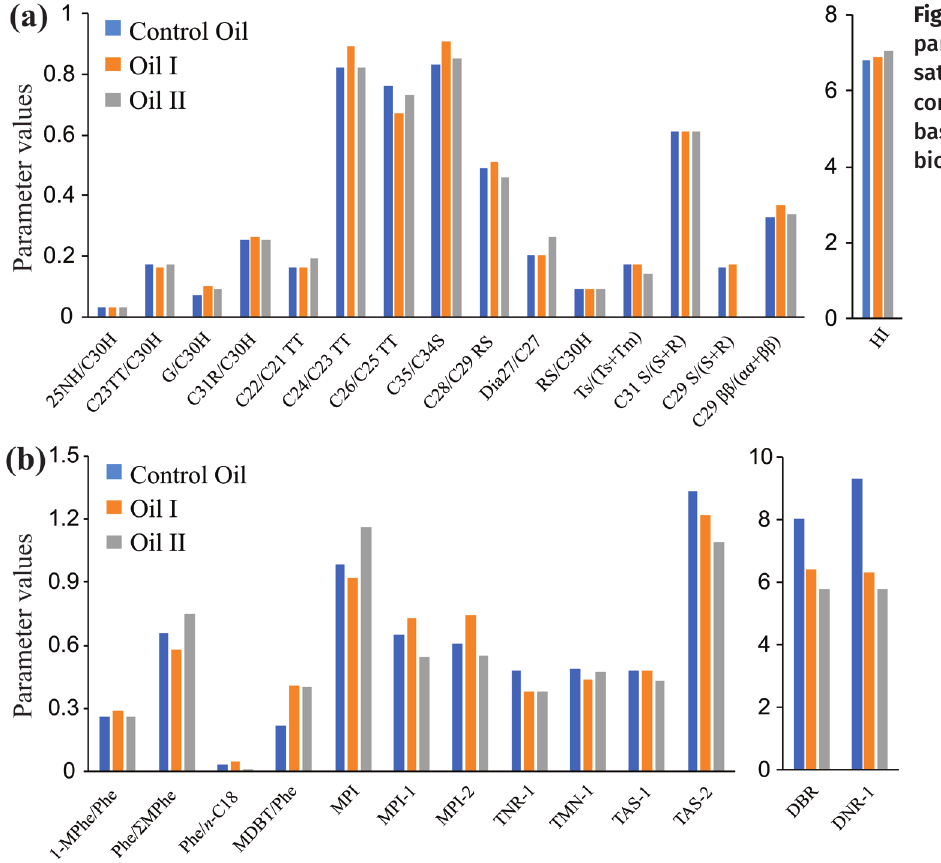
Figure 3. (a) Geochemical parameters based on the saturated biomarkers compounds, (b) and based on aromatic